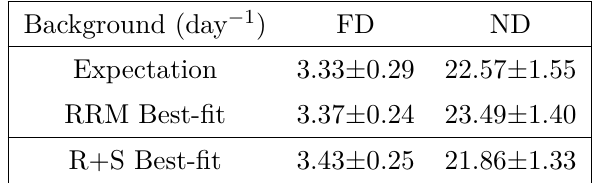
Table 3 . Cosmogenic background expectations and best-fit values in the FD and the ND. For comparison purposes, the last row shows the best-fit values obtained in the R+S analysis [9], restricted to the 1.0–8.5 MeV energy